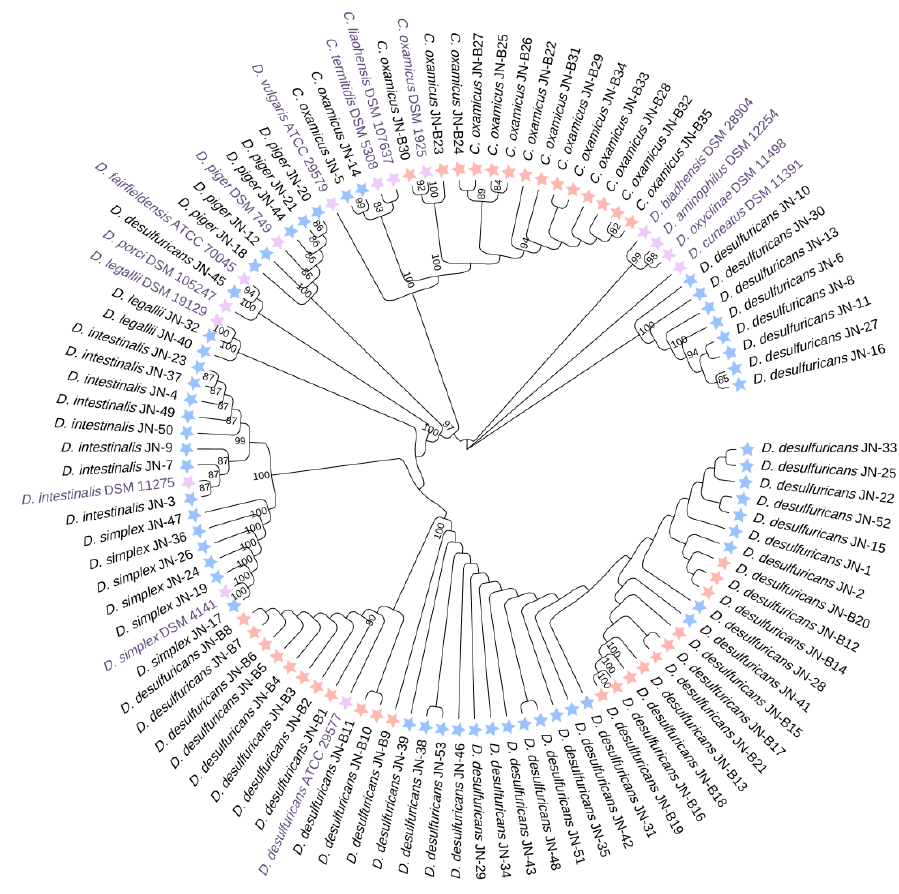
Figure 2. Phylogenetic analysis dendrogram of relationship sequences of 16S rRNA gene of Desul- fovibrio genera with Desulfovibrio isolated from the human gut. JN-1~53 were from HV (Healthy volunteers); JN-B1~B35 were from LC (patients with liver cirrhosis). The dendrogram was constructed by Neighbor-Joining methods using almost complete 16S rRNA gene sequences. The scale indicates the genetic distance between the species. Blue star means isolates from HV, orange-red star means isolates from LC, and purple star means type strains of Desulfovibrio and Cupidesulfovibrio .